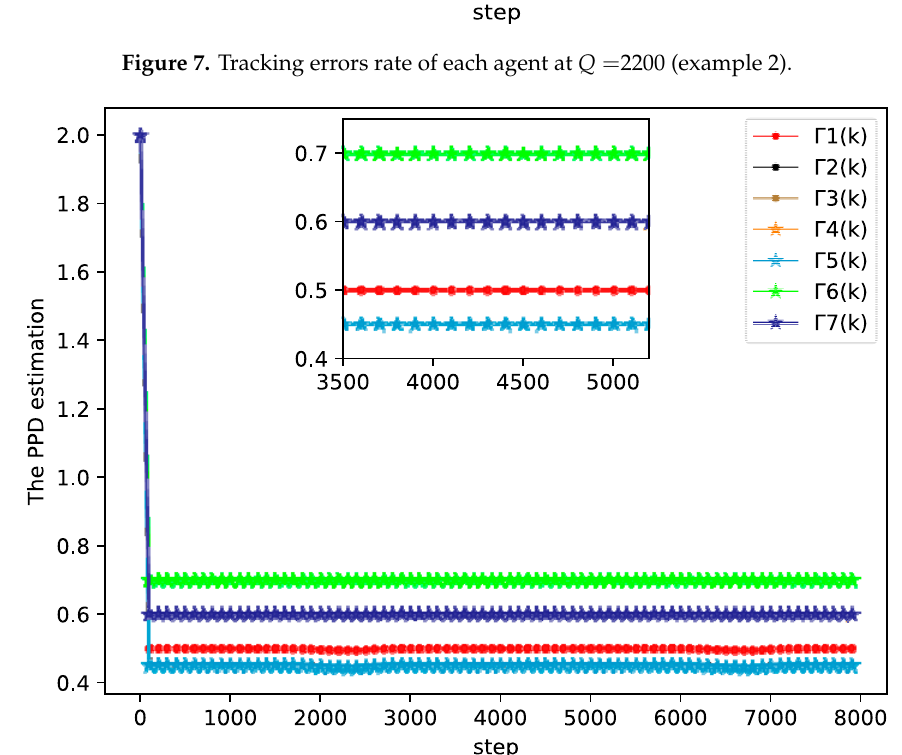
Figure 8. PPD estimation of each agent (example 2).